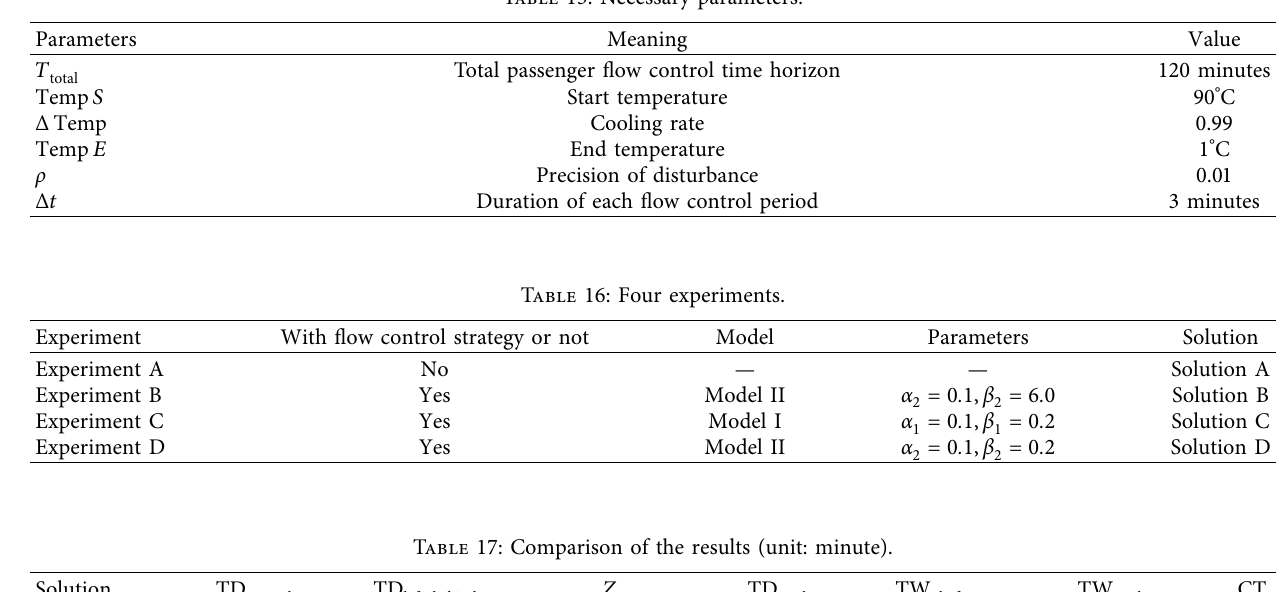
Table 15: Necessary parameters.